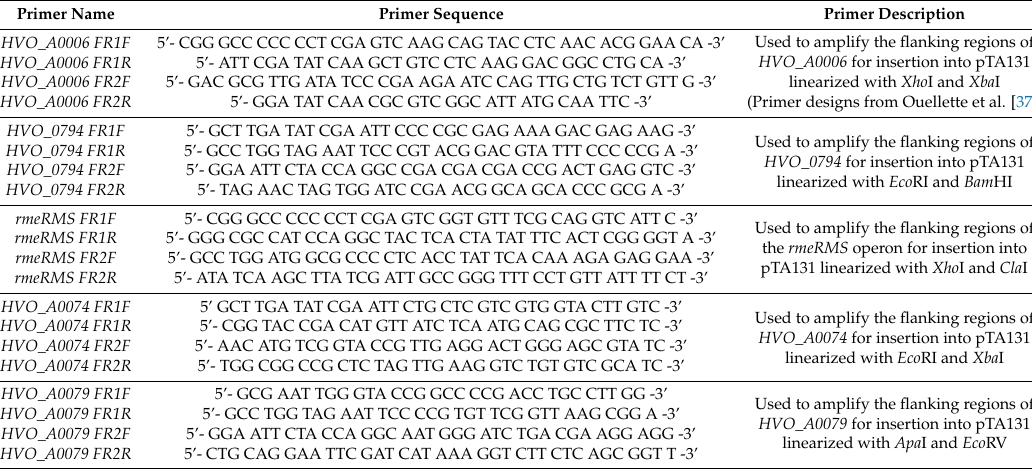
Table 3. List of primers used in this